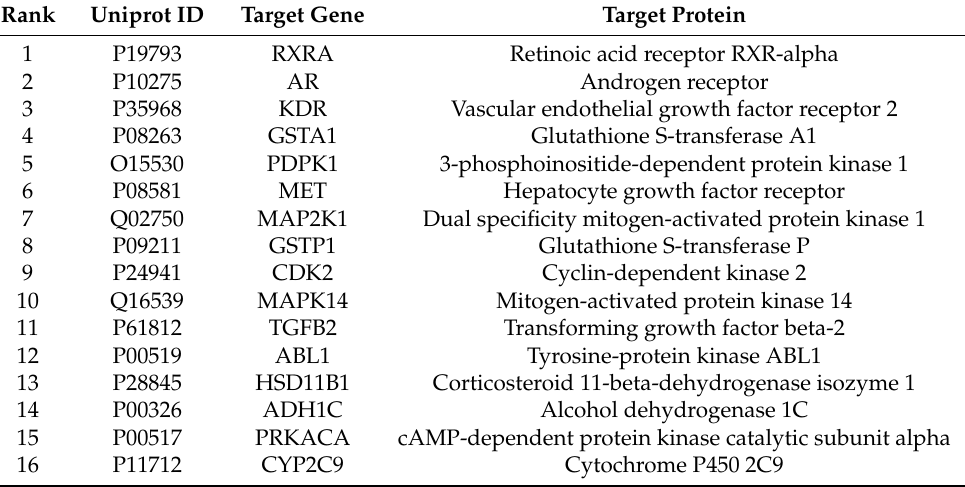
Table 4. The information of 16 potential related-tumor targets in S. alopecuroides .